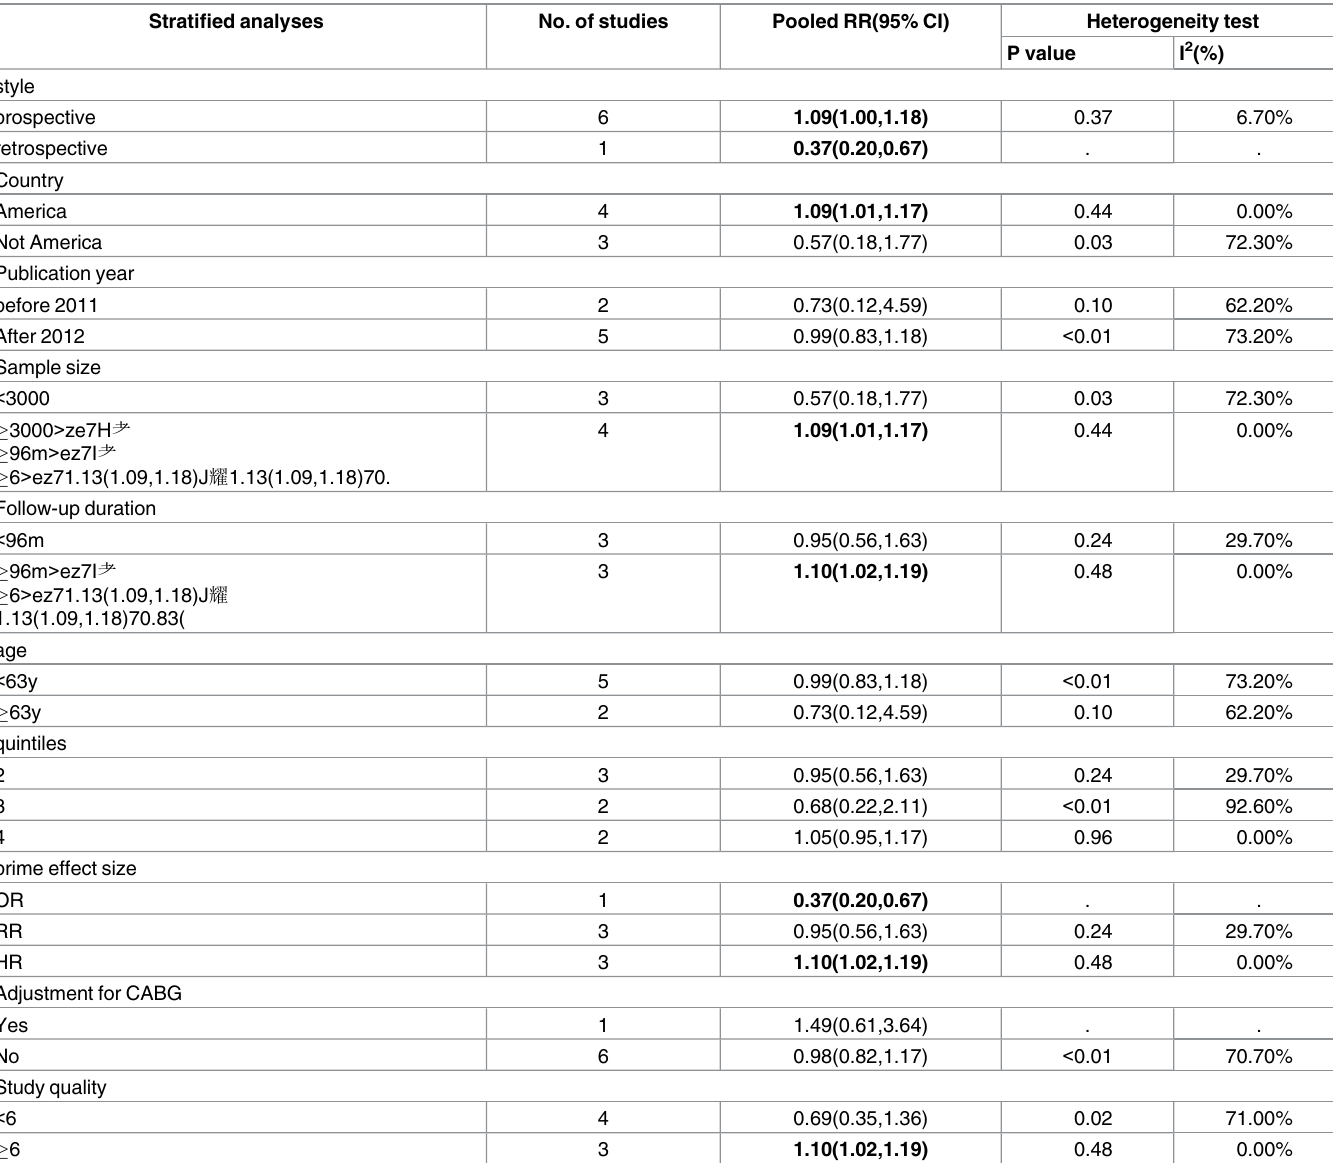
Table 3. Stratified analysesof pooled relative risks (95% CI) of AF for HbA1c levels as categorical